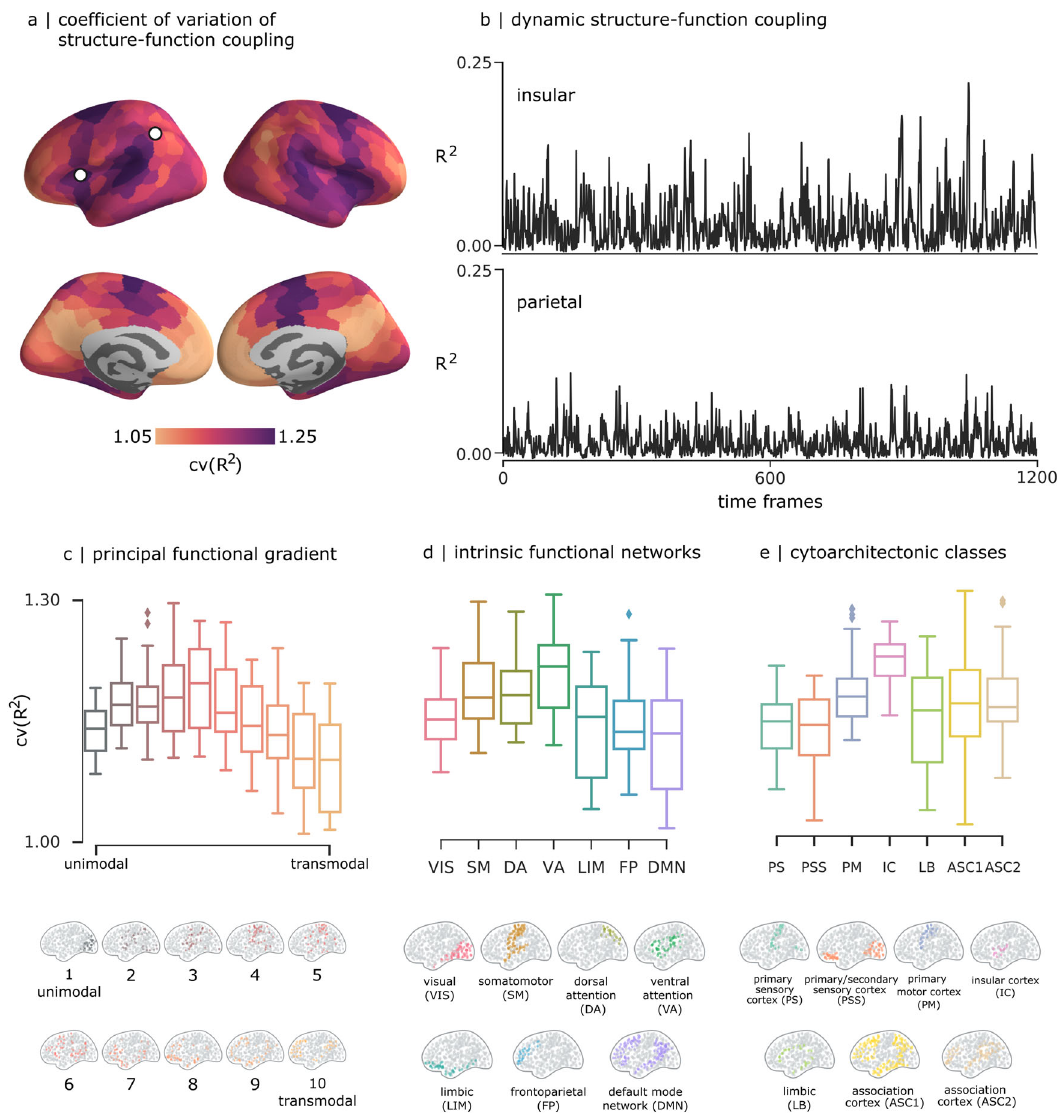
Fig. 3 Relationship with cortical hierarchies. a Coef fi cient of variation of structure-function coupling, averaged over all participants. b Time-series of regional structure-function coupling shown for one region in parietal cortex (left) and one region in insular cortex (right) from one randomly selected participant. The mean coef fi cient of variation is displayed for three types of cortical annotations: c 10 equally-sized bins of the principal functional gradient 41 , d intrinsic functional networks 40 , and e von Economo cytoarchitectonic classes 42